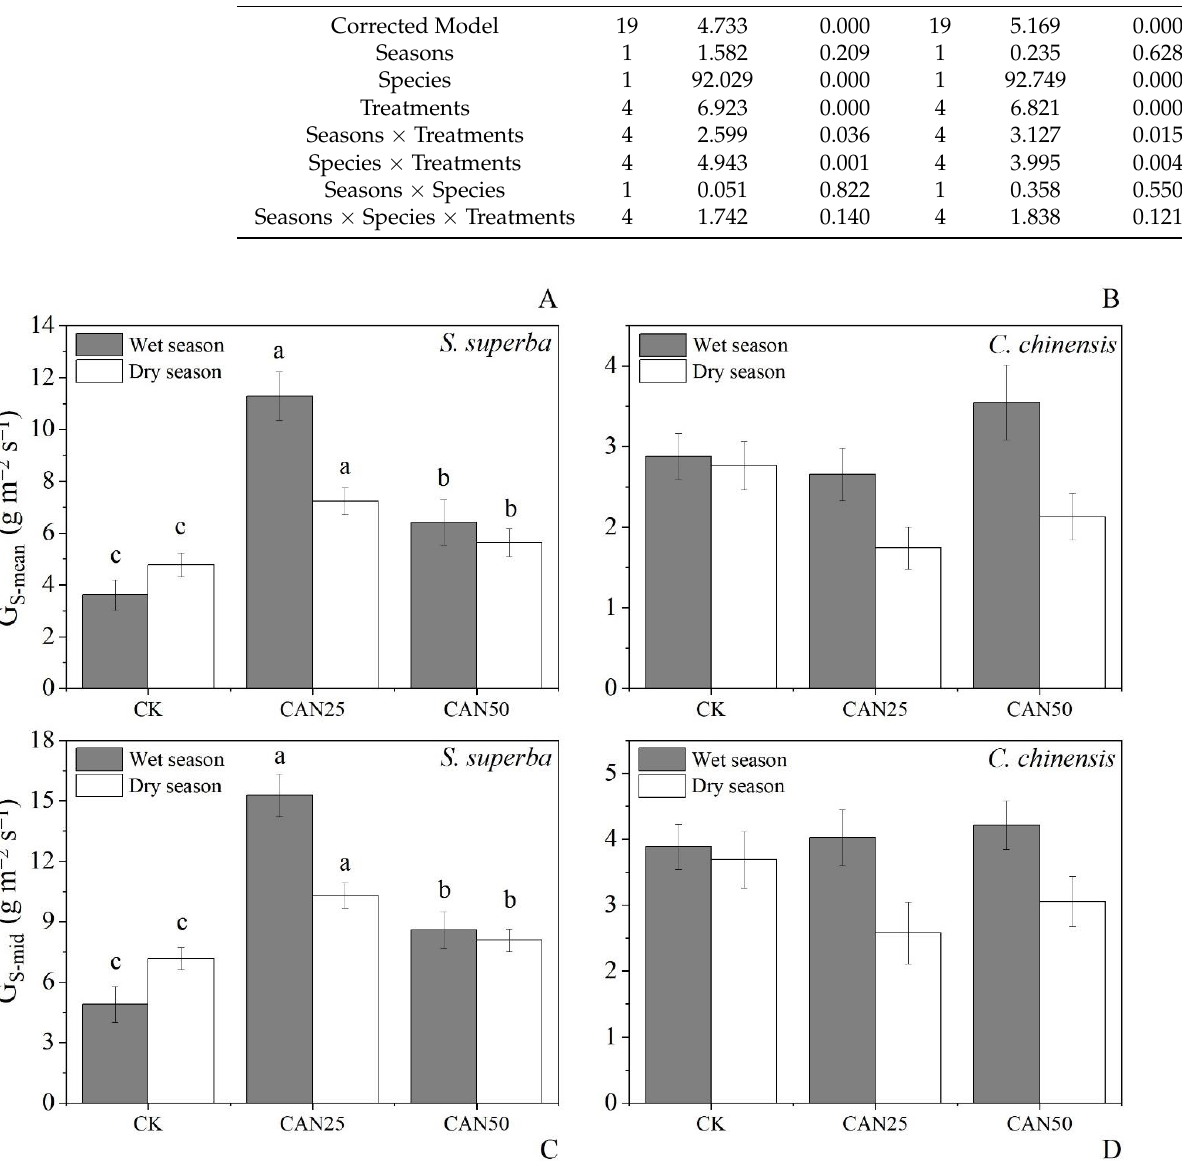
Table 2. ANOVA on the G S-mean and G S-mid .